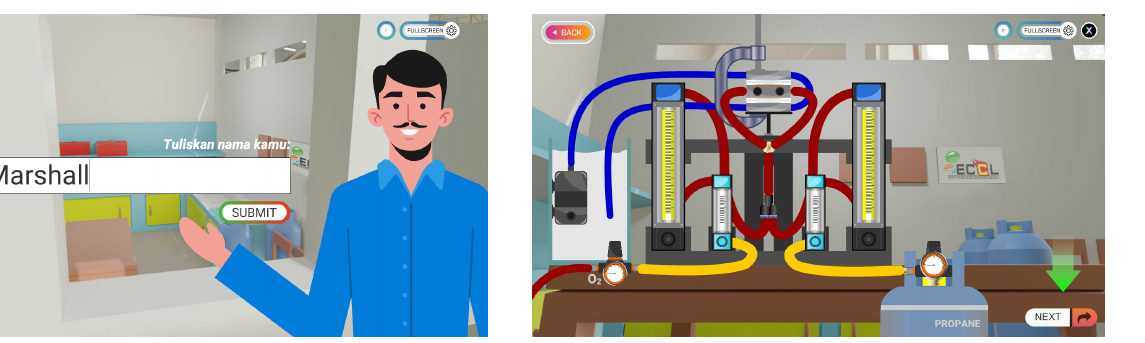
Figure 3: Log in virtual laboratory